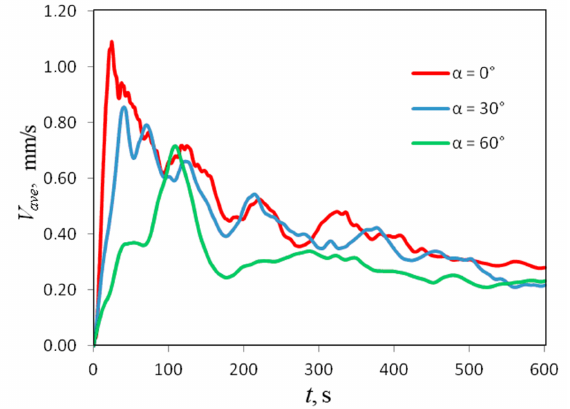
Figure 14. Temporal evolution of a domain-averaged convection velocity measured at different inclination angles of the slot.